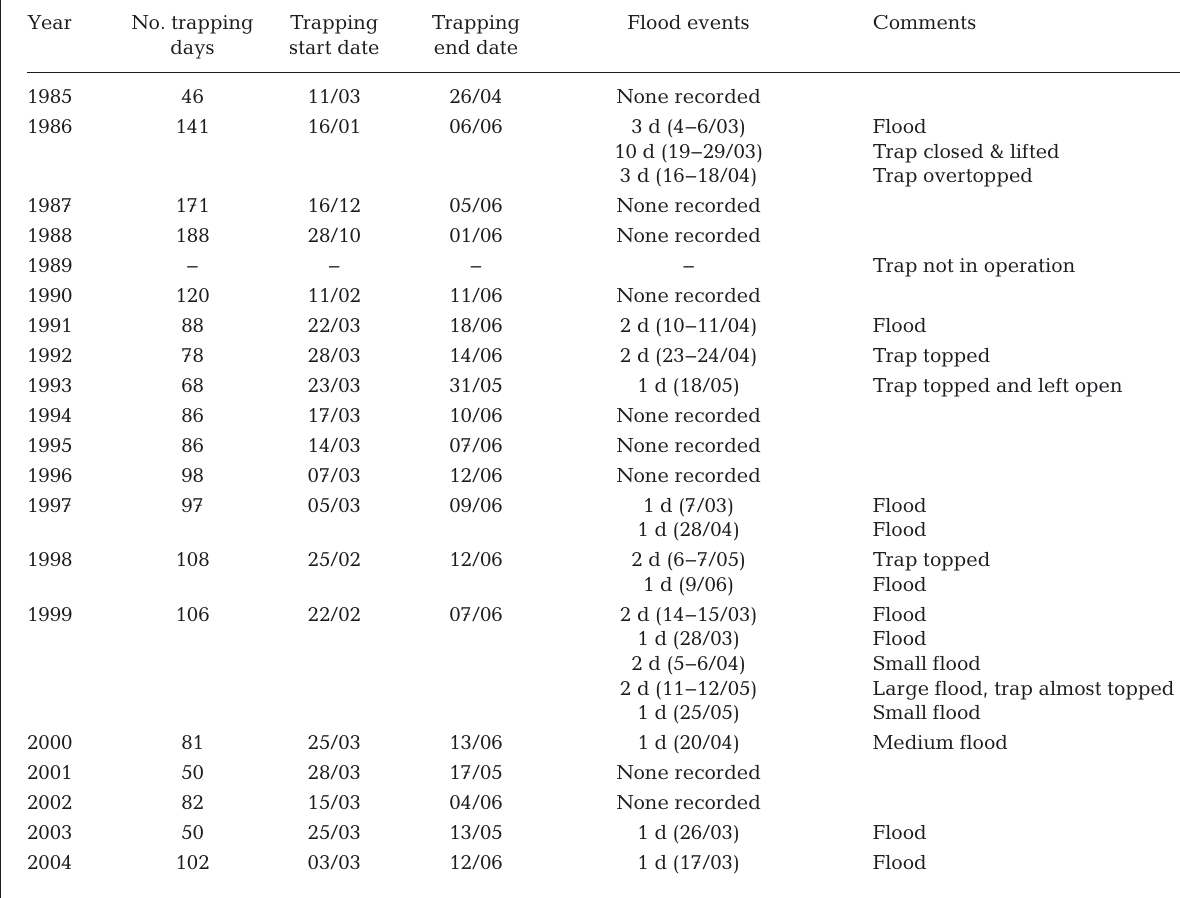
Table A1. Duration and start and end dates (given as dd/yy) of trapping at Tawnyard Trap, 1985 to 2004. Flood events and incidences of overtopping are